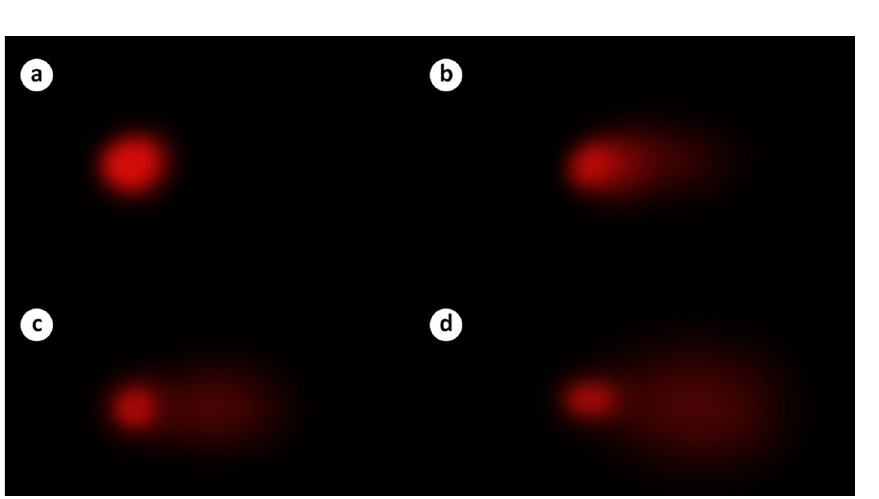
Figure 2. Comet assay analysis in leukocyte cell nuclei of Paraquat-treated mice. Control ( a ), 50 mg/kg b.w. Paraquat ( b ), 100 mg/kg b.w. Paraquat ( c ), 200 mg/kg b.w. Paraquat ( d